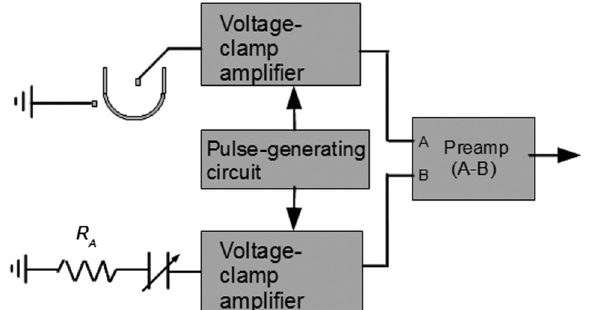
FIG. 5. Diagram of the electronics for the electrophysiology setup. The voltage-clamp amplifiers were home built with iden- tical components. The variable capacitor circuit has the purpose of canceling the bilayer’s capacitive current by subtracting a similar capacitive current from the signal. R A ¼ 10 K(cid:2) , and the tunable capacitor has a range of 20–150 pF.